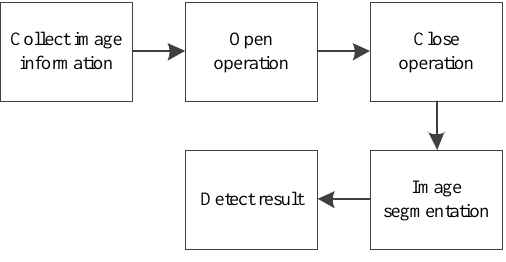
Figure 3. Image processing flowchart of FICA strips.